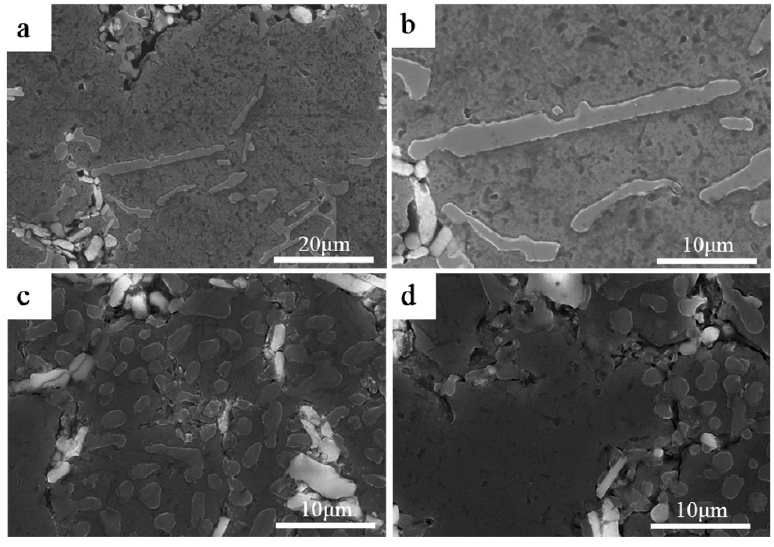
Figure 4. Al 2 O 3 /Al-20Si composite eutectic Si morphology ( a , b ) 0.02 GPa, ( c ) 3 GPa, ( d ) 4 GPa.